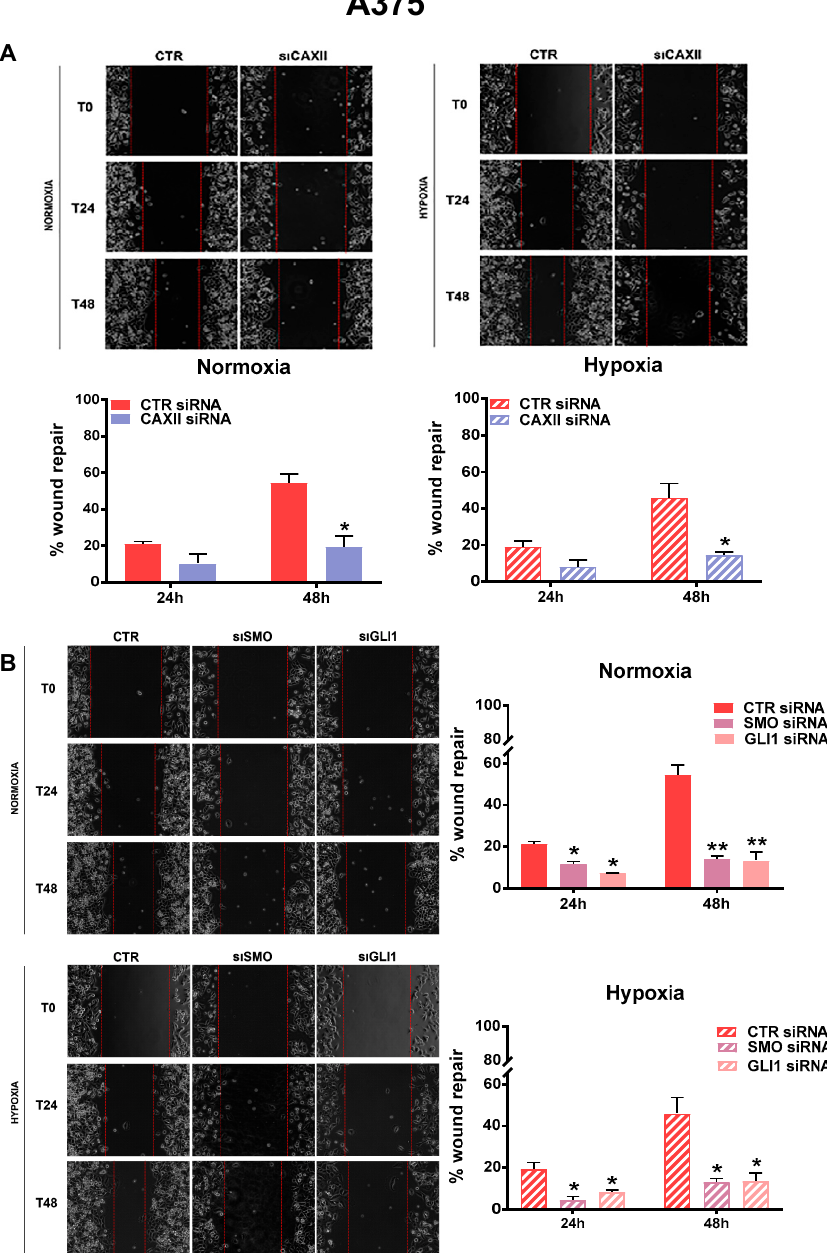
Figure 6. A375 cell migration was inhibited by CAXII, SMO, and GLI1 siRNA. Cell migration measured by wound-healing assays under normoxic and hypoxic conditions in A375 cells silenced with CAXII ( A ), SMO, and GLI1 ( B ). Pictures are representative of three independent experiments. Means ± SEM are presented. (n = 3; * p ≤ 0.05 and ** p ≤ 0.01 indicate statistically significant differences).